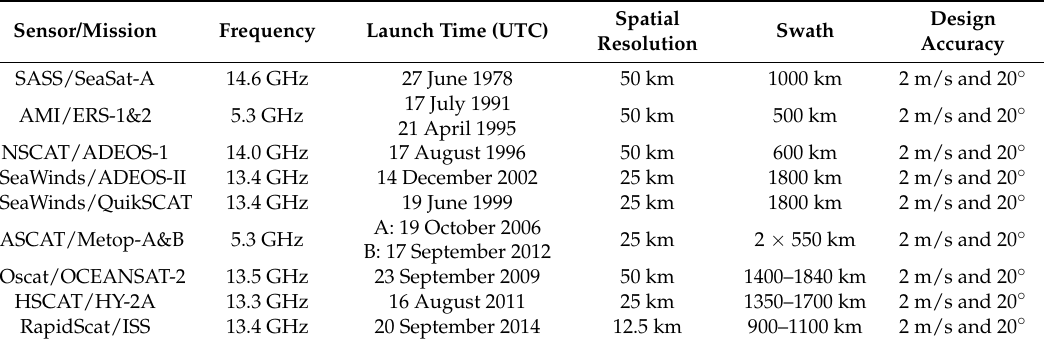
Table 1. The basic information of previous and on-going scatterometer